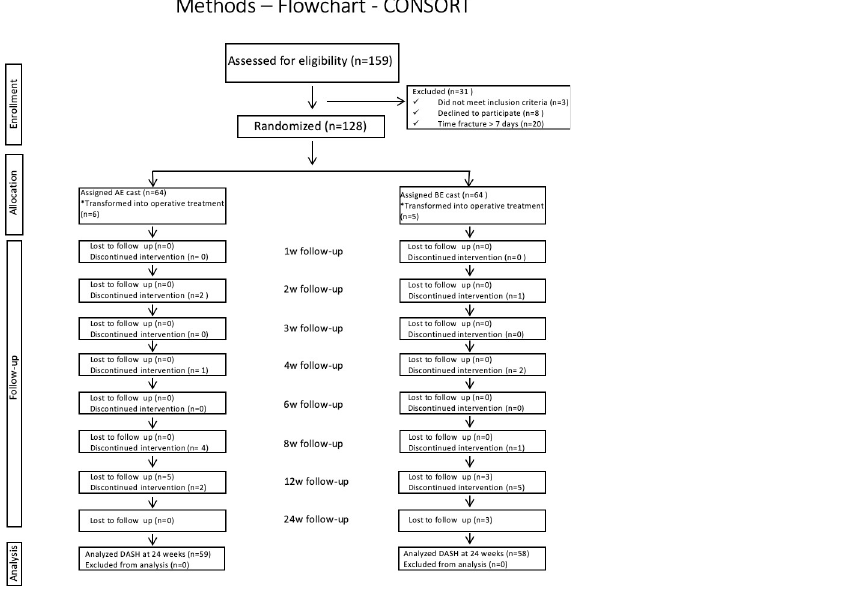
Fig 1. Flowchart according to